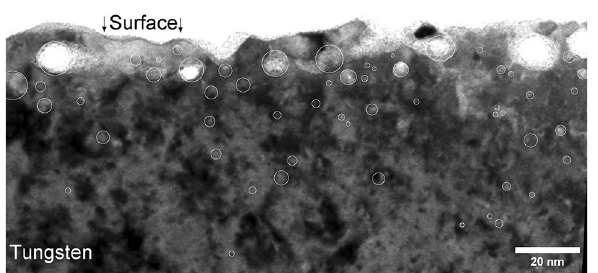
10 22 m − 2 s − 1 and 1053 K for 13 s showing ×